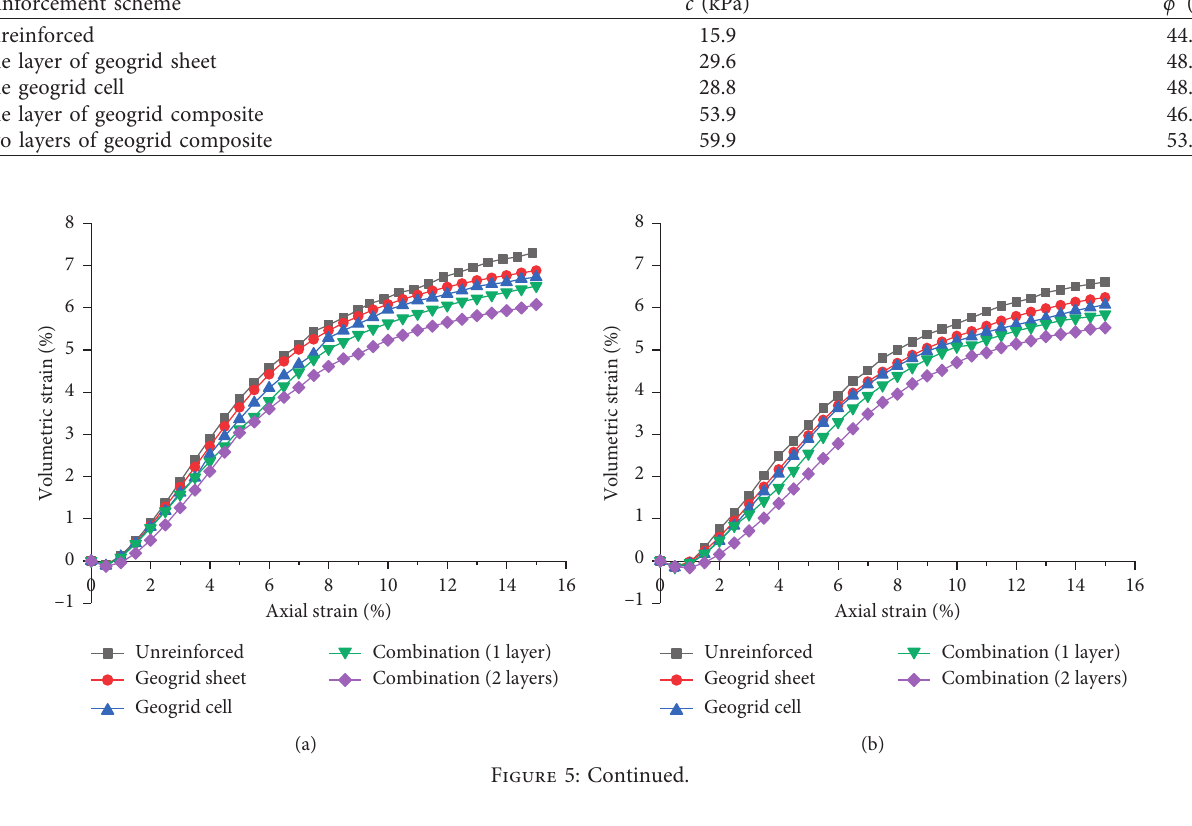
Figure 4: Deviatoric stress versus axial strain curves under different reinforcement forms. (a) σ (c) σ 3 � 100 kPa. Table 2: Strength indices of the soil specimens: the apparent cohesion ( c ) and friction angle ( ϕ ). Reinforcement scheme Unreinforced